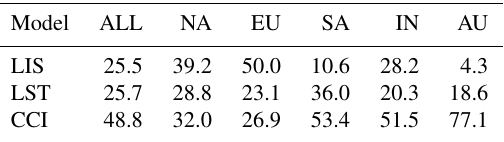
Table 3. Fraction of each macro-area (as a percentage) where one model outperforms the other